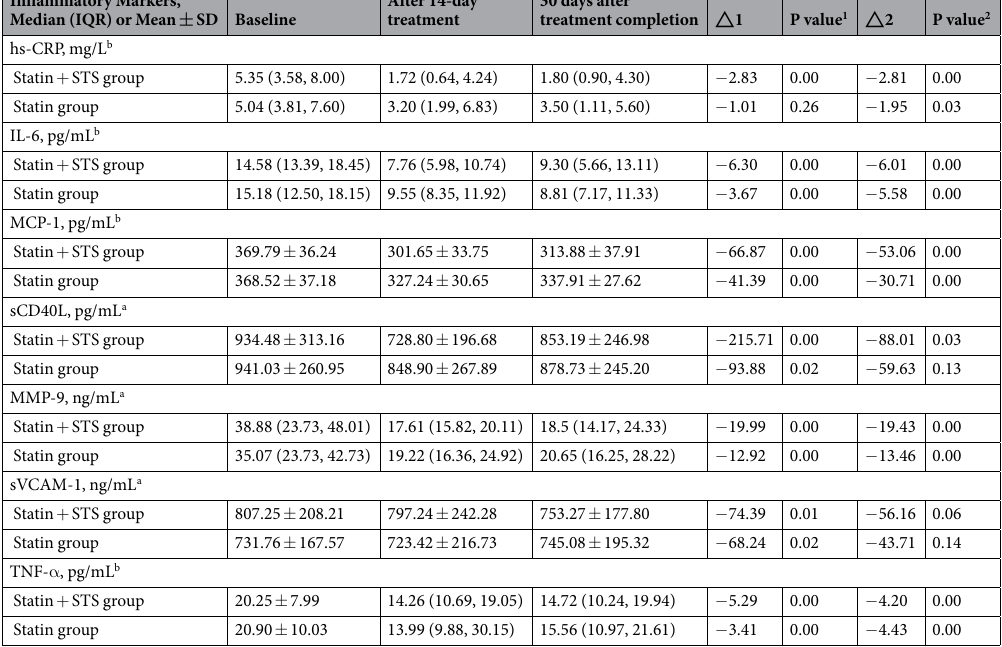
Table 3. Comparison of hs-CRP, IL-6, MCP-1, sCD40L, MMP-9, sVCAM-1, TNF- α levels within each group at baseline and after treatment. hs-CRP, high-sensitivity C-reactive protein; IL-6, interleukin-6; IQR, interquartile range; MCP-1, monocyte chemotactic protein-1; MMP-9, matrix metalloproteinase-9; sCD40L, soluble CD40 ligand; sVCAM-1, soluble vascular cell adhesion molecule-1; SD, standard deviation; STS, sodium tanshinone IIA sulfate; TNF- 𝛼 , tumor necrosis factor alpha. △ 1 indicates the intra-group difference between baseline and immediately after 14-day treatment. △ 2 indicates the intra-group difference between baseline and at 30 days after the completion of treatment. 1 p-value for intra-group comparisons between baseline and after 14- day treatment. 2 p-value for intra-group comparisons between baseline and at 30 days after the completion of treatment. a Intra-group comparison was analyzed using student’s t-test, due to normal distribution of the data. b Intra-group comparison was analyzed using the Wilcoxon rank-sum test, due to non-normal distribution of the